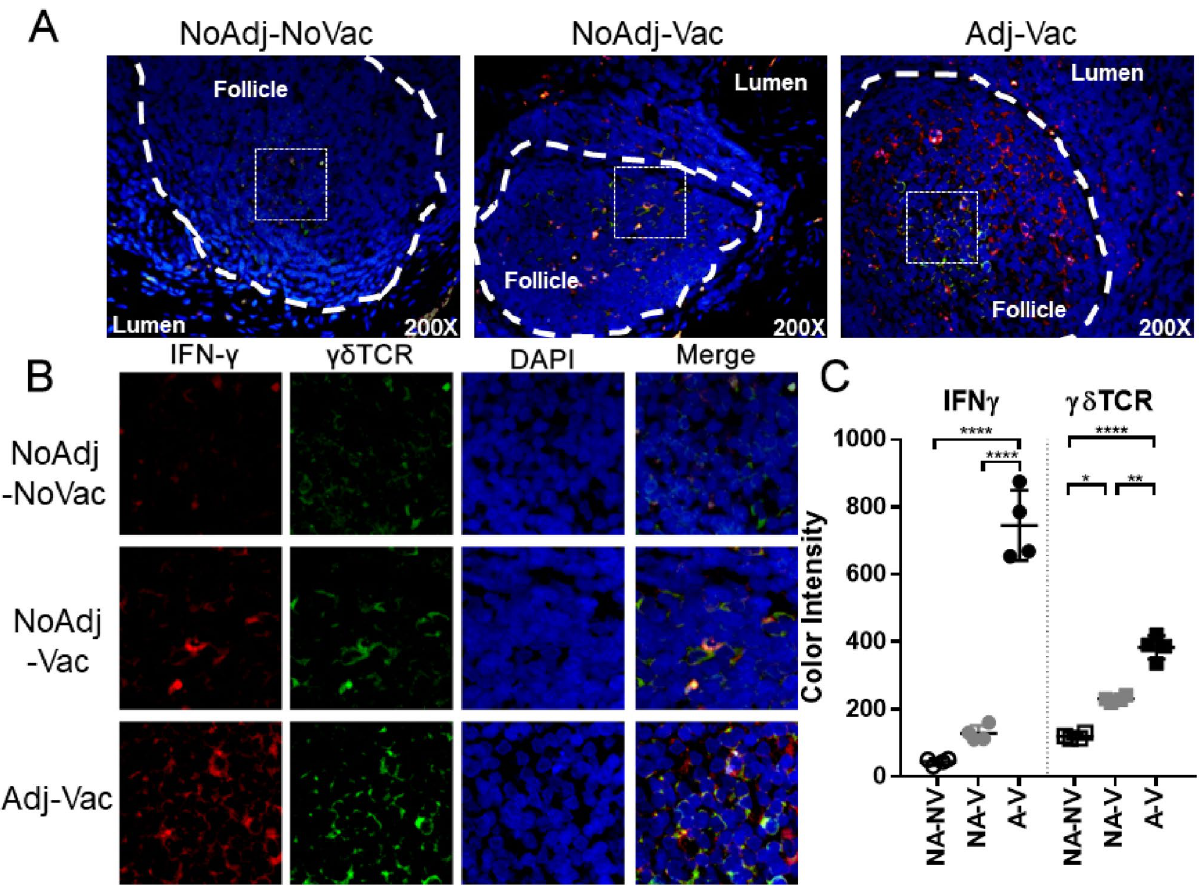
Figure 3. Increased abundance of IFNγ-positive cells in RAJ of cattle receiving adjuvanted vaccine. Characterization of cells within follicles of the recto-anal junction by immunofluorescent staining for either γδ TCR or IFNγ ( A , B ). Follicular region of RAJ was sectioned and labeled with florescent antibodies directed toward IFNγ (red) or γδTCR (green) and stained with nuclear stain DAPI (blue). Dashed lines indicate follicle boundary and hashed box indicate magnified section shown in ( B ) with representative section as indicated from an animal in non-adjuvanted-non-vaccinated (NoAdj-NoVac; NA-NV), non-adjuvanted-vaccine (NoAdj-Vac; NA-V), or adjuvanted-vaccine (Adj-Vac; A-V) groups. ( C ) Graphical representation of florescent data from indicated groups. Bars are ± SD. **** p < 0.0001, ** p < 0.01, * p < 0.05 one-way ANOVA with Tukey’s leukocytes (Fig. 1) or the type of lymphocytes present within the tissue (Fig. 2). Future studies which examine a time course of cellular infiltration or expansion either after vaccination, O157 challenge, or vaccination and chal- lenge would be valuable in identifying important lymphocyte populations leading to reduced fecal shedding. We have demonstrated in a previous study that animals injected with the adjuvanted only preparation had no effect on E. coli O157:H7 shedding and failed to induce circulating IgG response 12 . However, additional immunological assessment of adjuvant-only treatments could be performed in the future study to help delineate the usefulness of vaccine formulation within the context of adjuvant-directed, cell-specific host responses. IFNγ can be an important mediator of macrophage activation or changes within the mucosal epithelium to prevent bacterial infiltration 39 . Here, an increase of follicle formation within the mucosa, which was accompanied by an increase in IFNγ-producing cells, associated to previous findings showing that vaccination of animals with the adjuvanted vaccine formulation was important in reducing the magnitude and duration of fecal shedding of O157 12 . Similar to these current findings, others have demonstrated that the fecal shedding kinetics of a low- shedding E. coli strain of O157:H7 compared to a high shedding strain did correlate with increased IFNγ and other Th1 skewing transcripts within the low-shedding group 32 . Here, the primary focus included IFNγ and IL-10 receptor gene expression as these genes relate to the protein and cellular expression previously documented by our group 18 , however many other inflammatory genes were analyzed and found to be significantly differential between the experimental groups (Fig. 4, Supplementary Table S1). Further studies to identify biological sig- nificance of these findings are necessary. Outside of intestinal aspects of IFNγ, when dairy cows were pre-treated with recombinant IFNγ and chal- lenged intra-mammary with E. coli , animals demonstrated reduced duration of infection and lower clinical scores of mastitis compared to non-treated animals 40 . Effects of IFNγ on E. coli strains outside of ruminant hosts have also been explored. Administration of recombinant IFNγ to avian pathogenic E. coli -challenged chickens